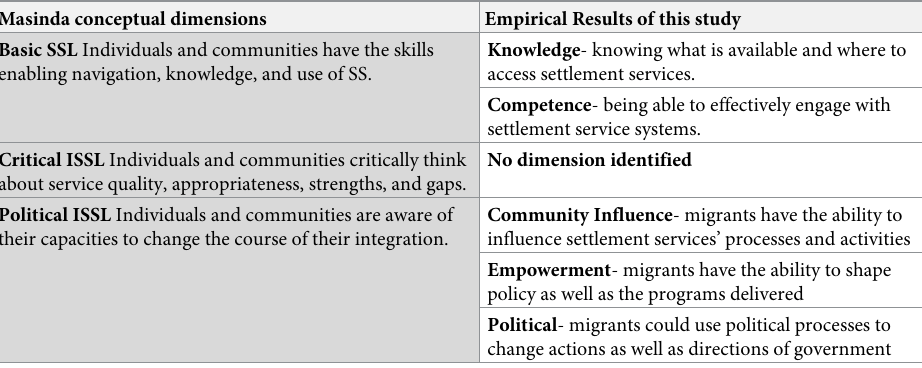
Table 5. Dimensions of settlement service literacy. Masinda conceptual dimensions Empirical Results of this study Basic SSL Individuals and communities have the skills enabling navigation, knowledge, and use of